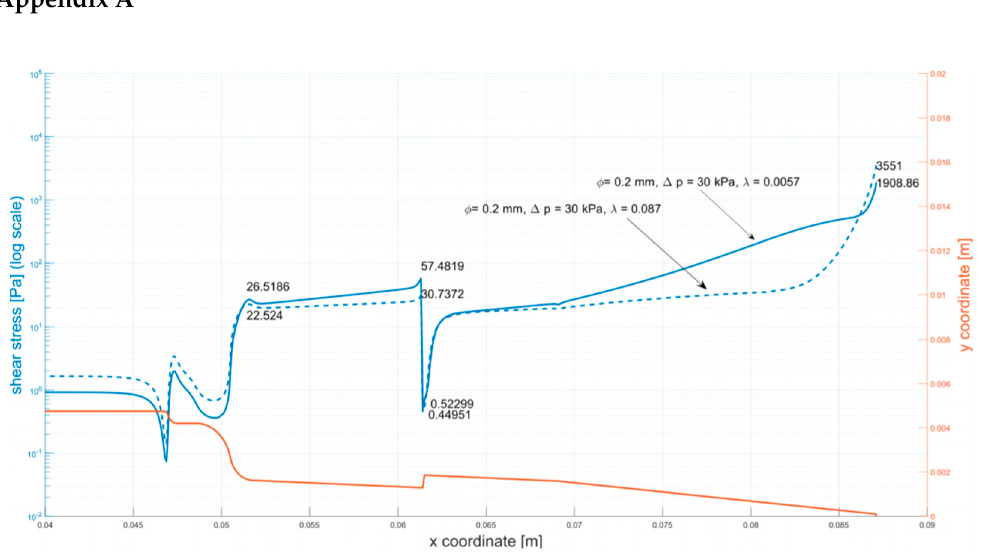
Figure A3. Shear stress at the walls of the cartridge ( φ = 0.2 mm, ∆ p = 100 kPa). Figure A4. Shear stress at the walls of the cartridge ( φ = 0.58 mm, ∆ p = 50 kPa).